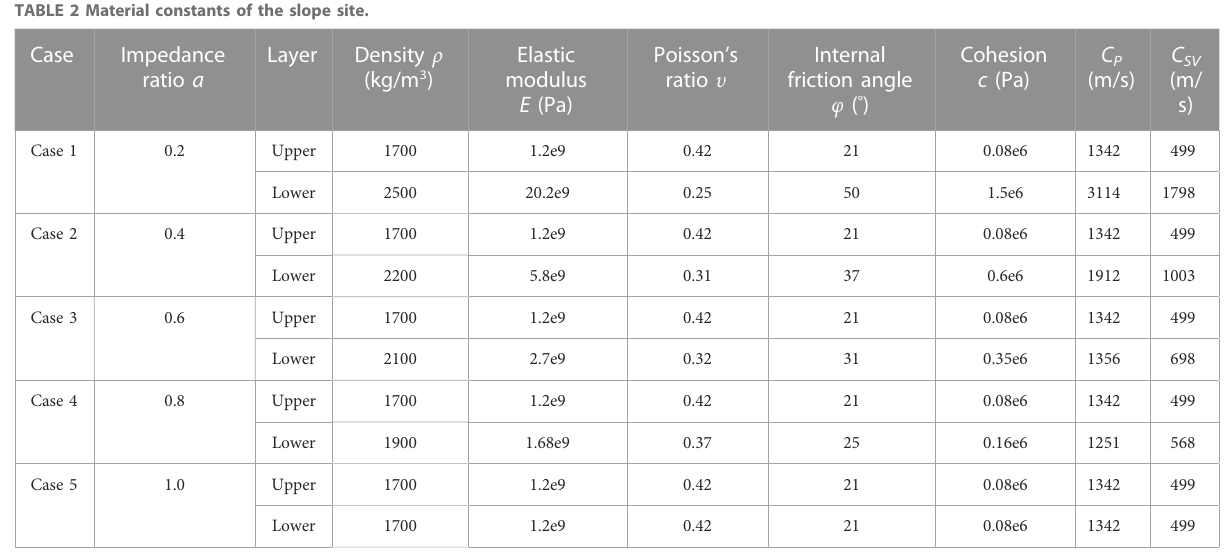
TABLE 2 Material constants of the slope